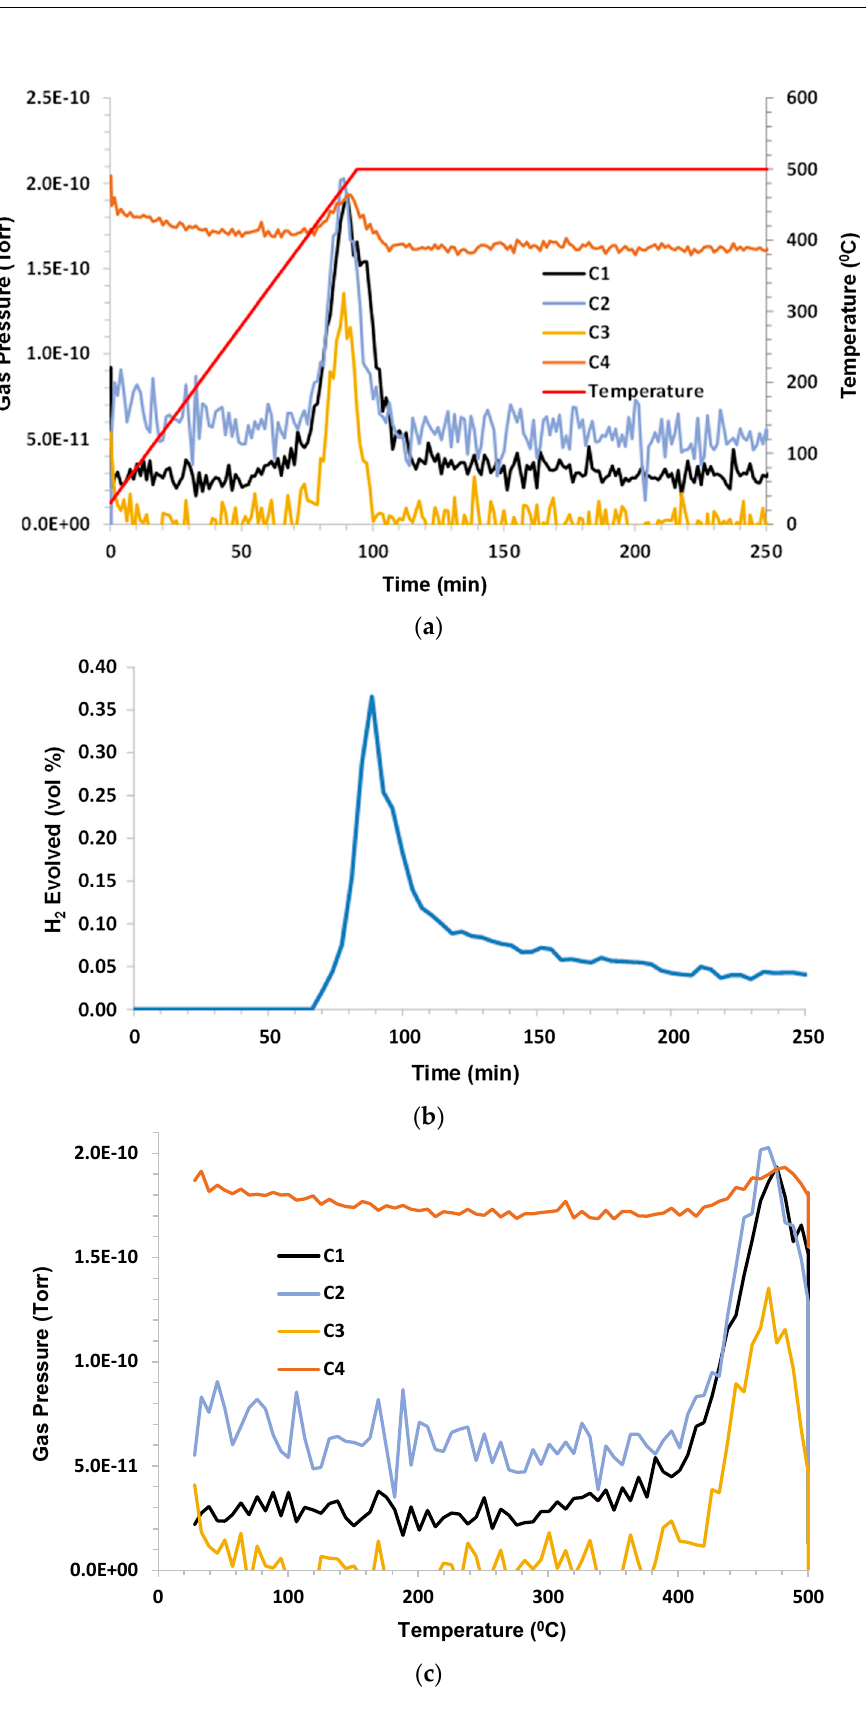
Figure 4. Asphalt Ridge in humid CO 2 . ( a ) Gas pressure and temperature as a function of time. ( b ) H 2 evolved (vol%) as a function of time. ( c ) Gas pressure as a function of temperature.